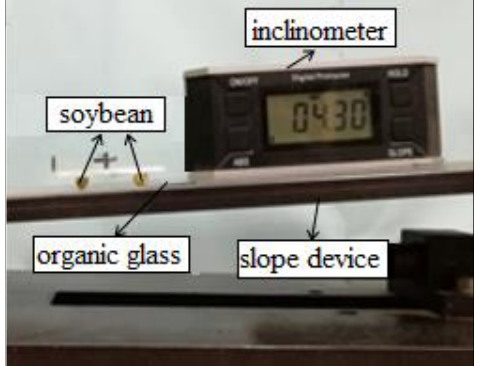
Figure 6. Static friction coefficient between soybean seed particle and boundary measured by the slope method.